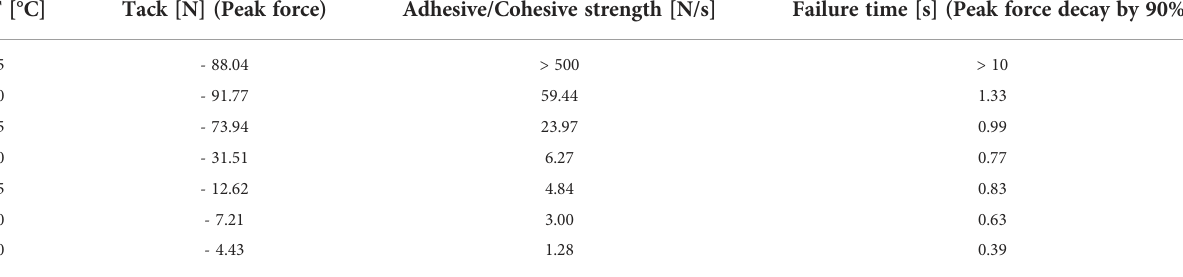
TABLE 1 Peak forces, adhesive and cohesive strengths, and failure times of Scots pine cone resin under different temperatures regimes at a lifting speed of 1 mm/s. T [°C] Tack [N] (Peak force) Adhesive/Cohesive strength [N/s] Failure time [s] (Peak force decay by